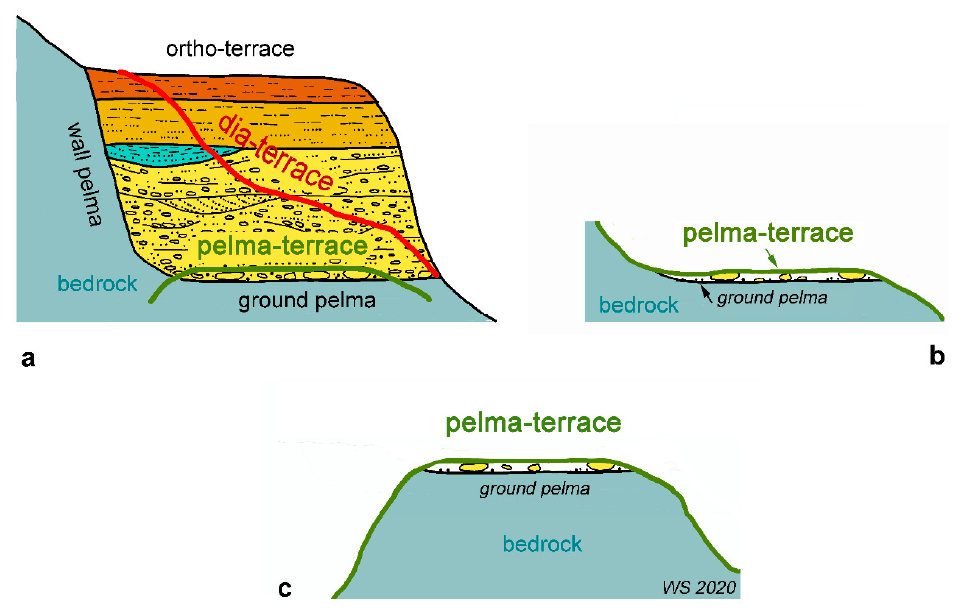
Figure 5. Pelma-terrace: a complete flument ( a ) eroded down (green line) to the basal facies leaving only the lag layer and the ground pelma (contact of the basal facies with the bedrock), ( b ) with a backwall, ( c ) crowning a hilltop. Normally, the pelma-terrace deposit is a loose litter of pebbles.